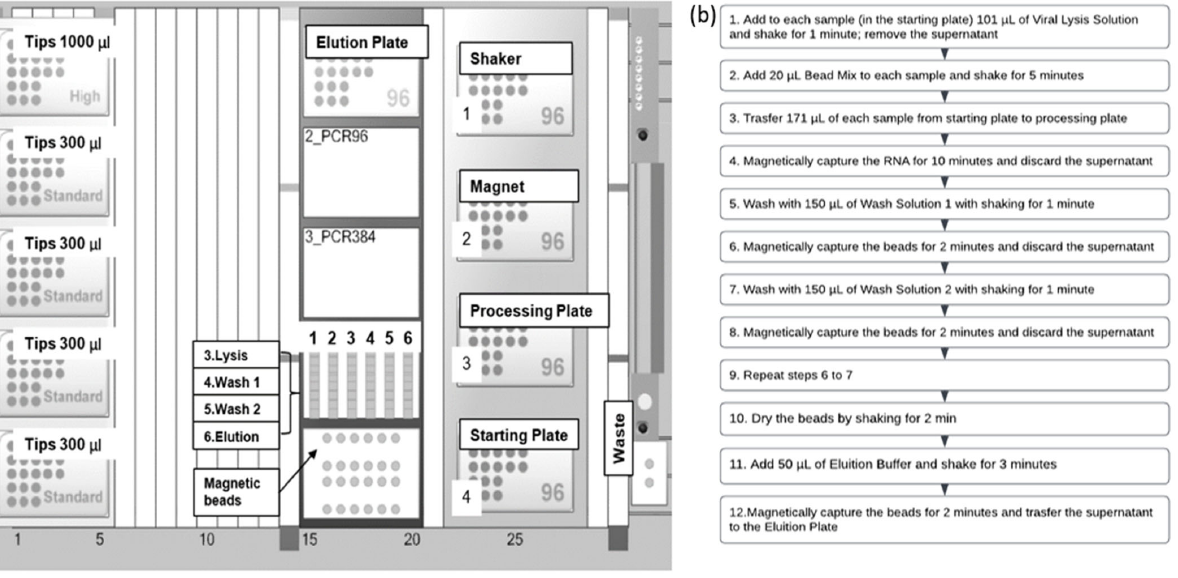
Figure 1. Details of automated extraction protocol: ( a ) set ‐ up of working desk, ( b ) extraction protocol.